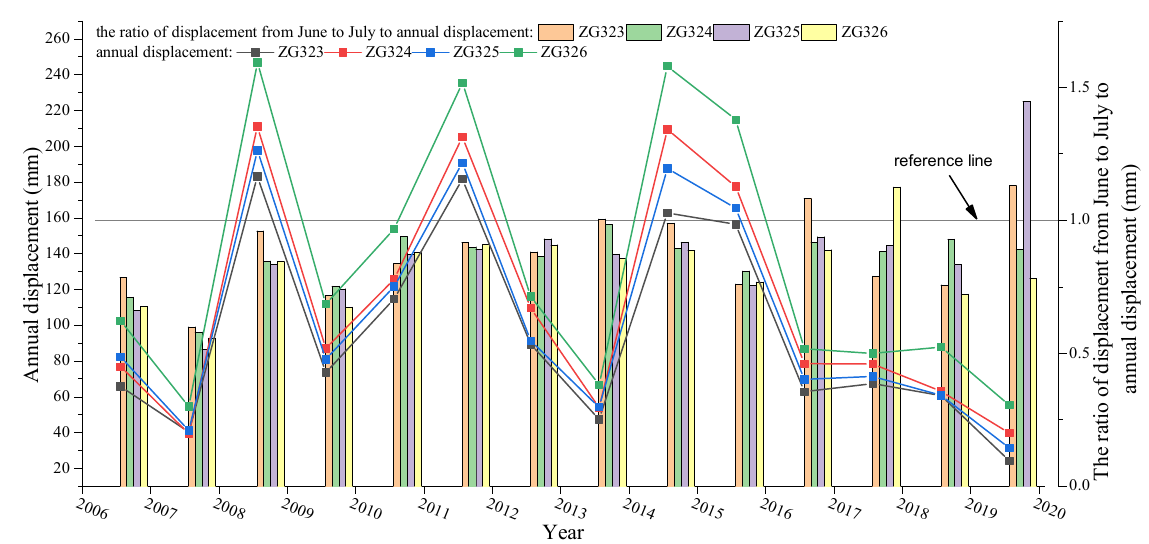
Figure 9. Annual displacement and the ratio of displacement from June to July to annual dis- placement.